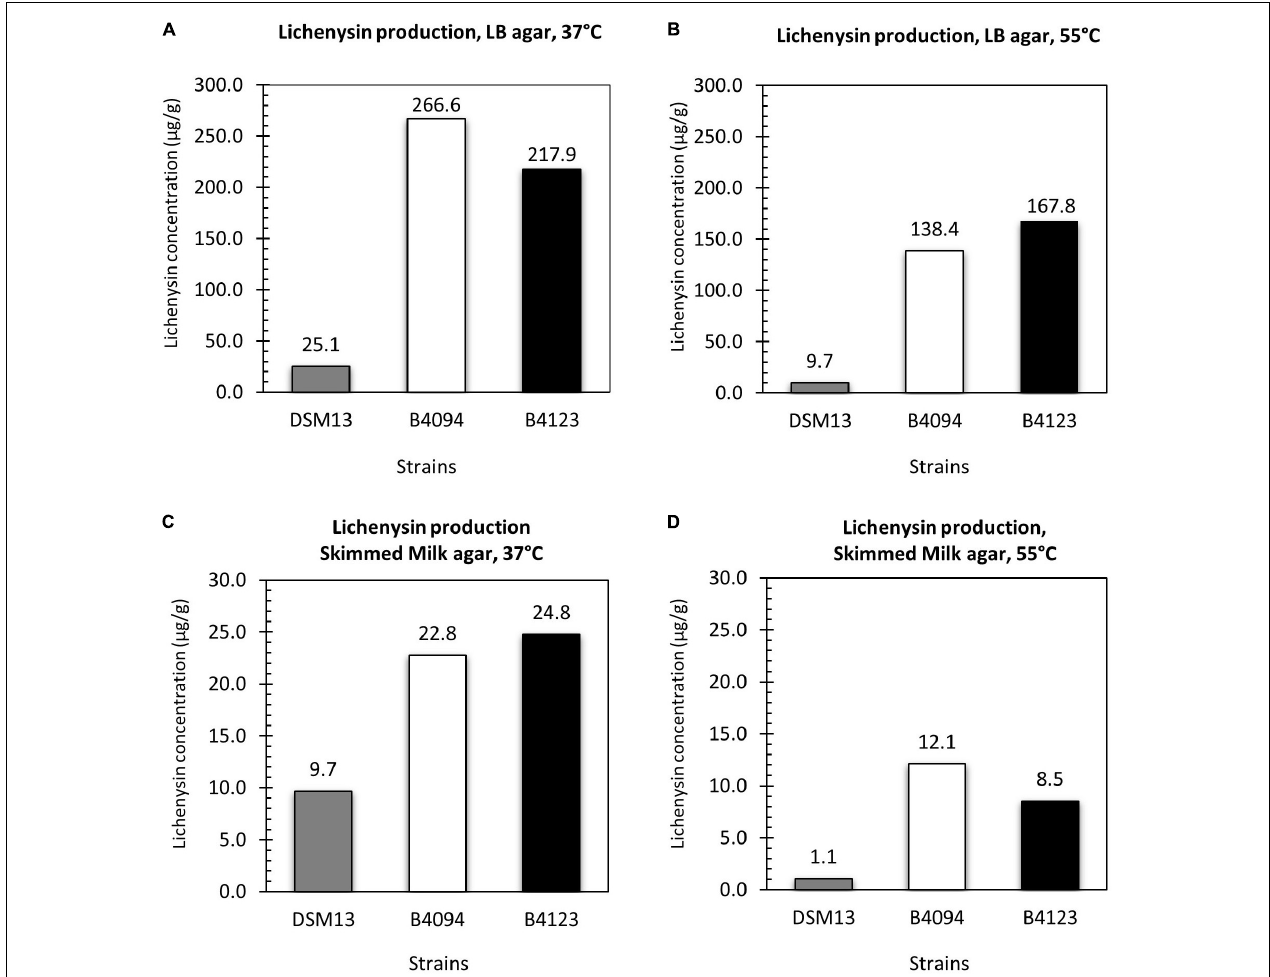
FIGURE 5 | Lichenysin production upon surface growth on LB agar and skimmed milk at 37 and 55 ◦ C. Total lichenysin produced by DSM13 T , B4094, and B4123 per g of wet biomass after 10 days of incubations on (A) LB agar at 37 ◦ C; (B) LB agar at 55 ◦ C; (C) skimmed milk agar at 37 ◦ C; (D) skimmed milk agar at 55 ◦ C. Gray bar- DSM13 T , white bar- B4094, black bar-